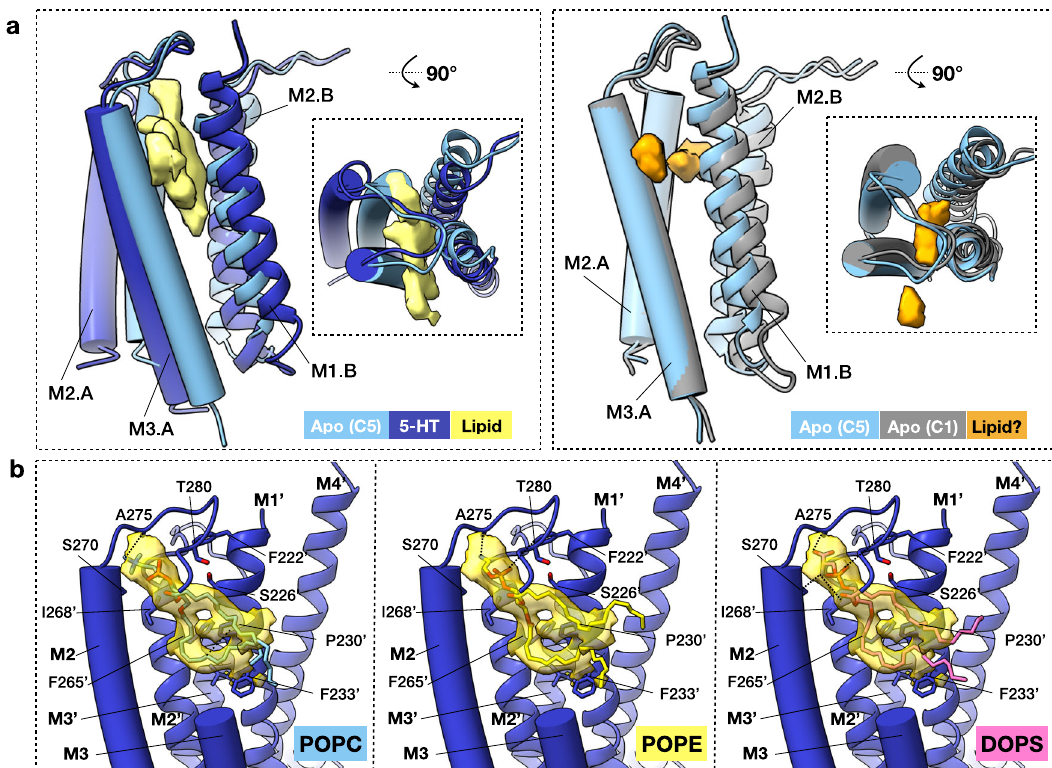
Fig. 7 Inter-subunit lipid-like EM densities. a Additional densities tentatively assigned as lipids (yellow) were seen in between subunits at the TMD for the serotonin-5HT 3 R-Salipro EM map (left). Weaker densities were seen in the largest inter-subunit cavity of the apo-C1 EM map (right). b Tentative modelling of POPC (left), POPE (middle), and DOPS (right) in the inter-subunit phospholipid-like density (transparent dark yellow, contoured at σ 2.0) of the serotonin-5HT 3 R-Salipro EM map. Residues P281-L293 of the M3 helix (of chain A) are omitted for clarity. TMD helices of chain A and B are shown in tube and ribbon representation,